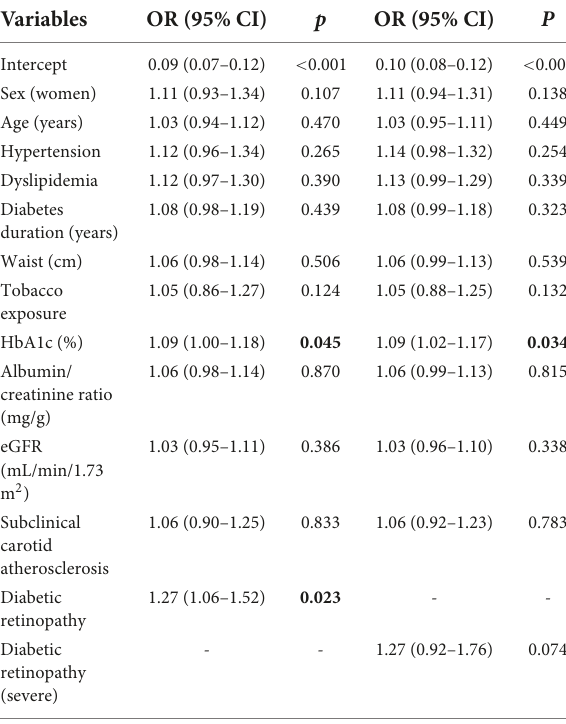
TABLE 2 Regularized logistic regression models for the association between the different variables, including plaque and diabetic retinopathy, and incident major adverse cardiovascular